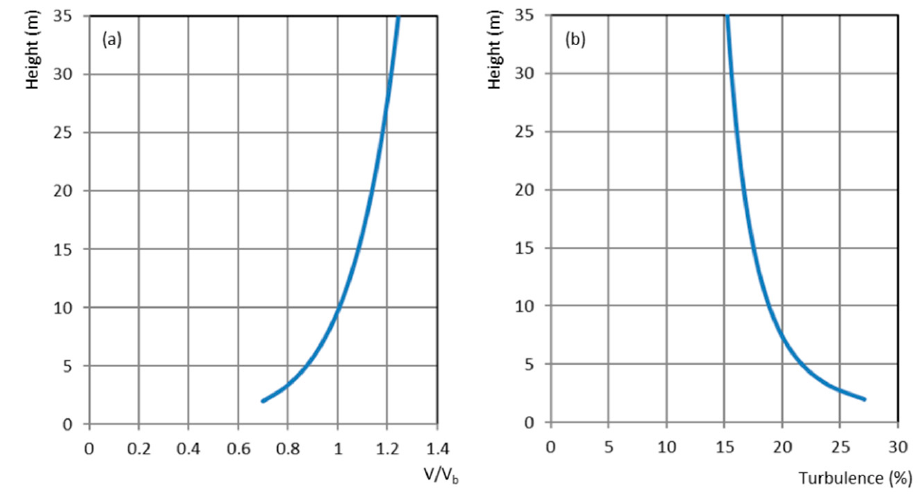
Figure 12. ( a ) Wind velocity vertical profile and ( b ) turbulence for a terrain category II according to the Eurocode 1-4 [57].